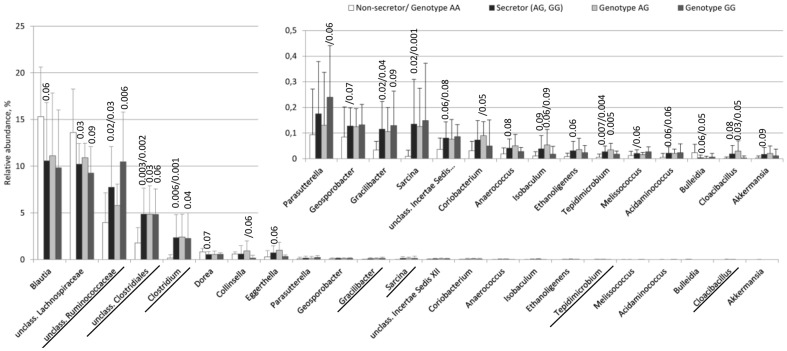
Mean relative abundances of the bacterial genera showing significant (ANOVA/indicator species analysis, p<0.05) or trend-like differences (p<0.09) between the non-secretors (n = 12) and the secretors (n = 12) or between the FUT2 genotypes AA (n = 12), AG (n = 7), GG (n = 5).The statistical significance is indicated for a comparison of the secretors/FUT2 genotypes AG and GG to the non-secretors/FUT2 genotype AA. The taxa significantly differing in both indicator species analysis and ANOVA test are underlined.